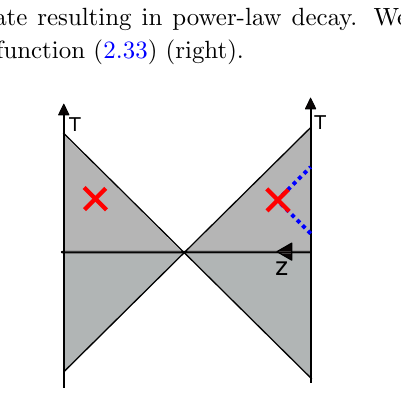
LC (cid:31) C/M , IR LC (cid:30) C